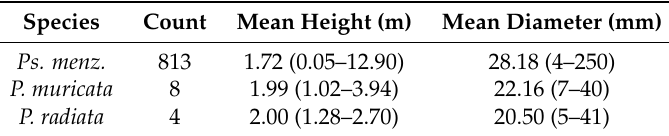
Table 1. Field tree data summary with range shown in brackets. Diameters shown were measured at breast height (1.4 m) for larger trees and ground level for saplings.